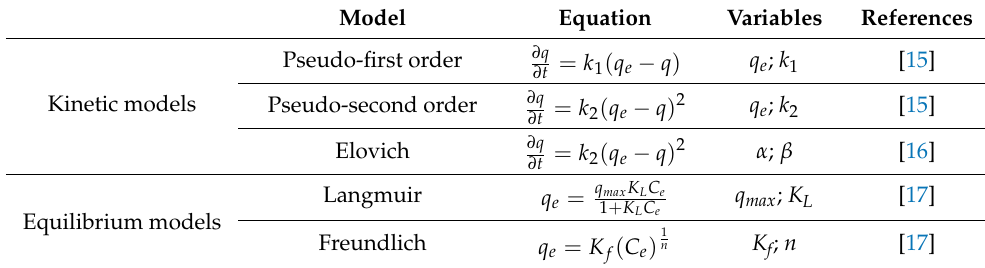
Table 1. List of the equilibrium and kinetic